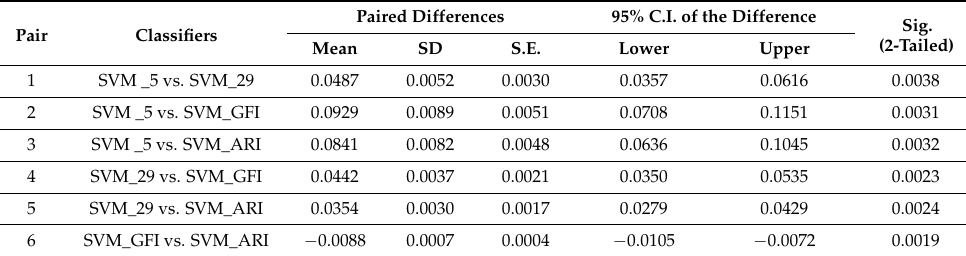
Table 6. Paired sample t test of the sensitivity of SVM classifiers.